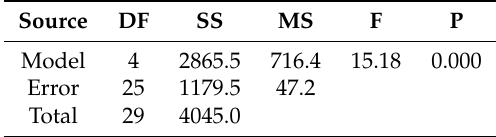
Table 5. ANOVA: duration vs. die-nozzle